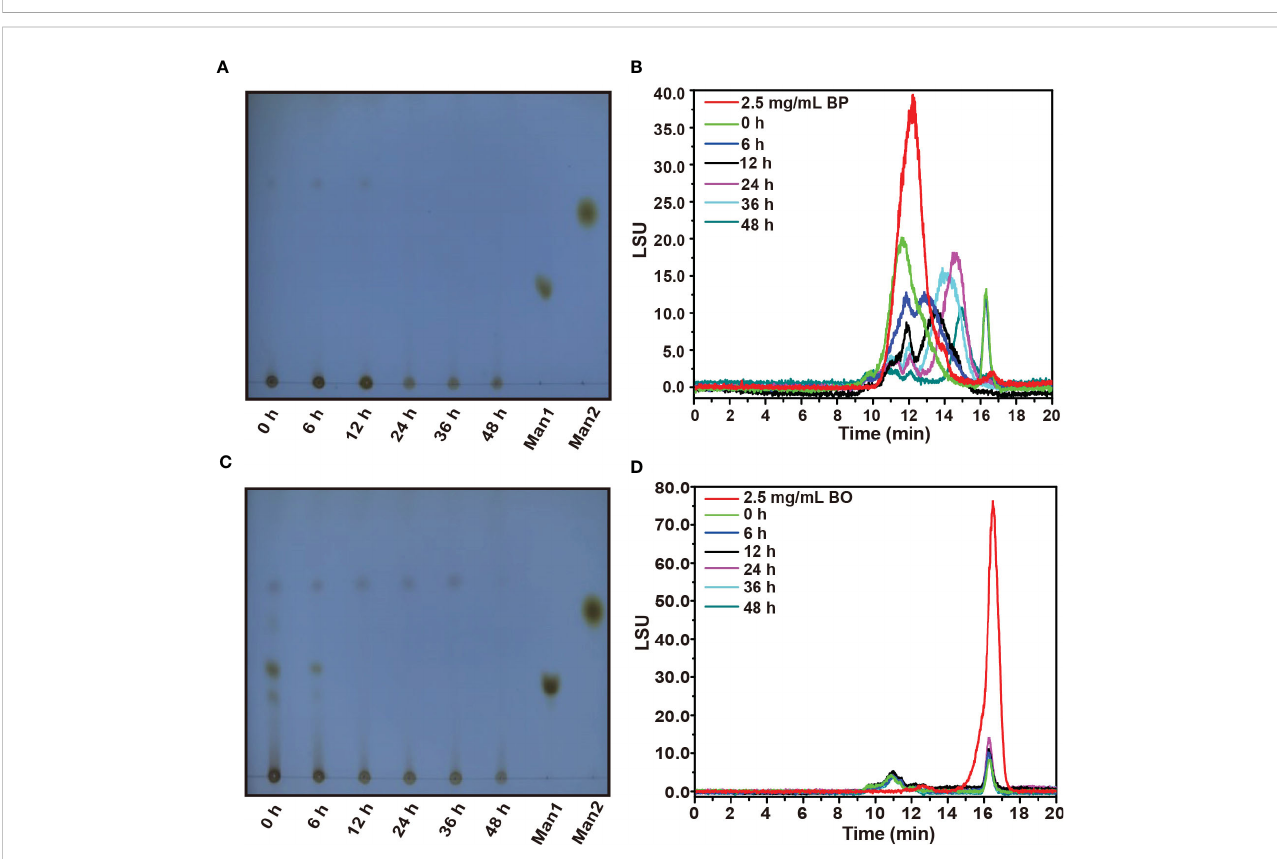
FIGURE 3 TLC and HPGPC analysis on degraded oligosaccharide products of BP and BO by gut microbiota during in vitro fermentation. (A, B) Molecular weight change of BP degradation products by TLC (B) and HPGPC (A) assay. (C, D) Molecular weight change of BO degradation products by TLC (C) and HPGPC (D) assay. Man1:D-(+)-Mannose; Man2: a